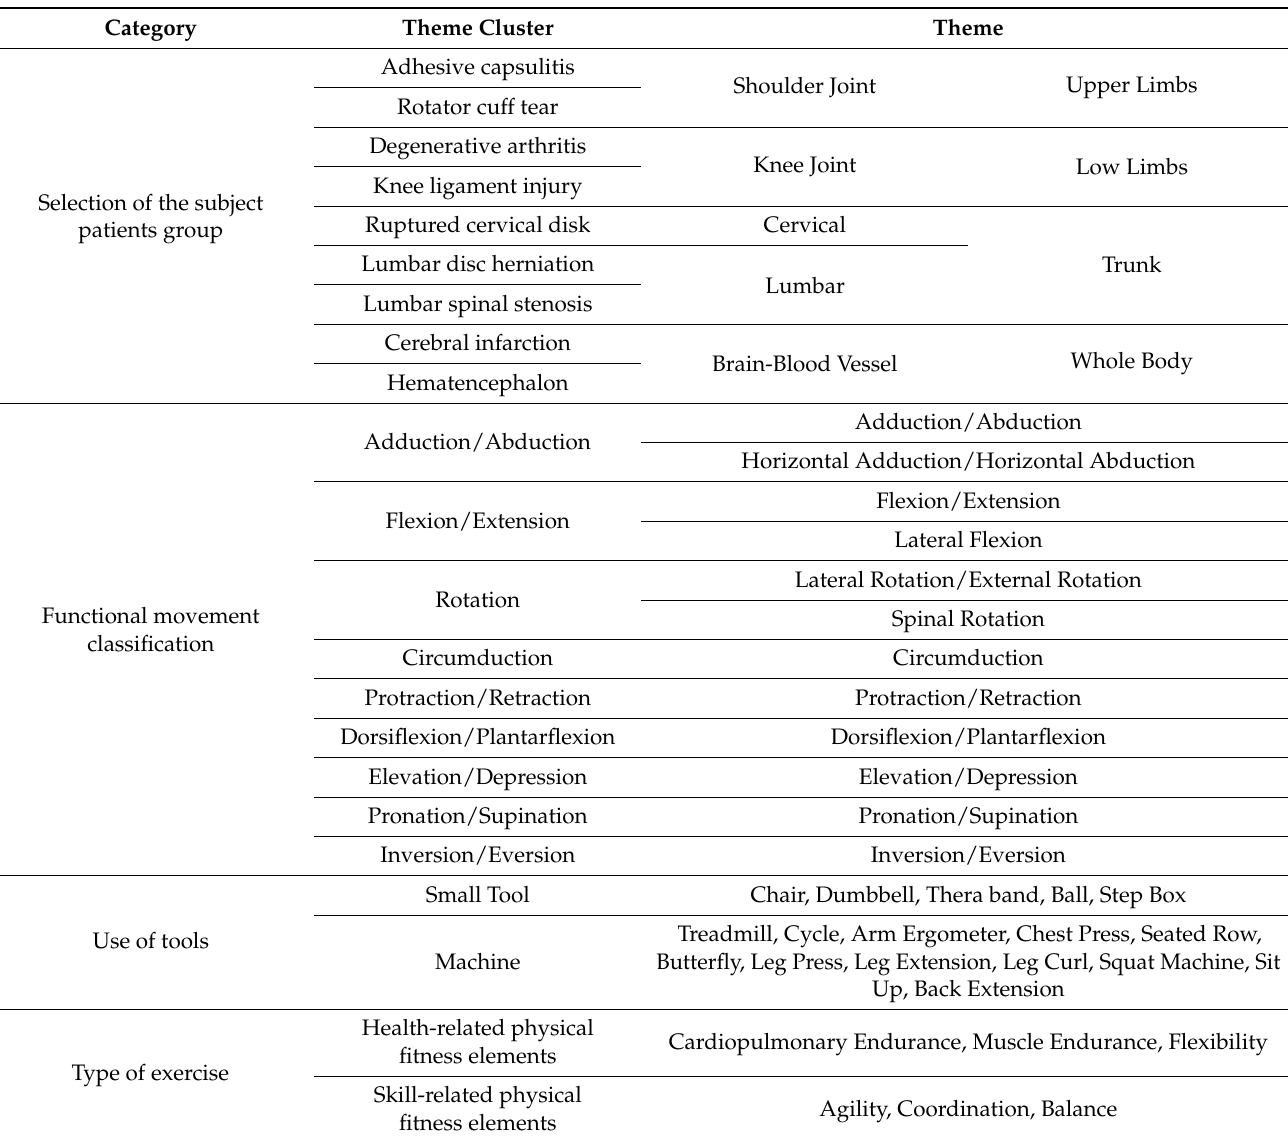
Table 3. Results of ICT-based exercise rehabilitation services component extraction and systematiza- tion of